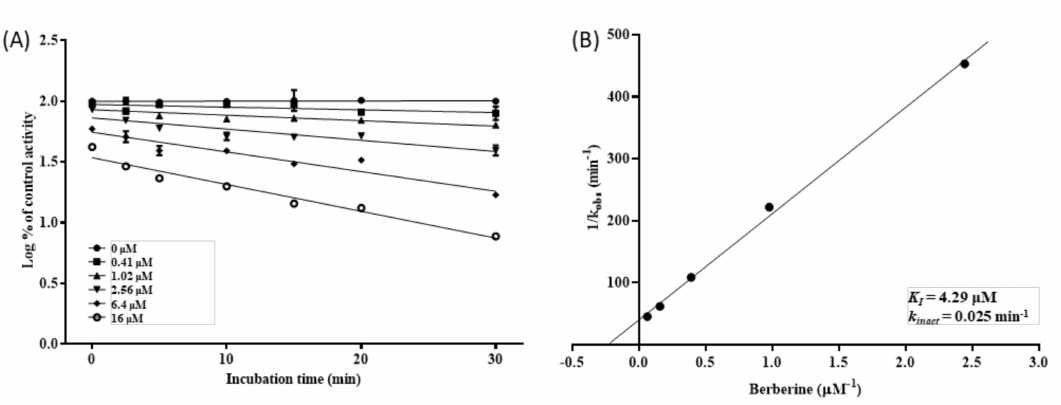
Figure 4. Time-dependent inhibition of CYP2D6 by BBR. ( A ) BBR was incubated for 0, 1, 5, 10, 15, or 30 min with NADPH in pooled HLM. CYP2D6 activity is expressed as the log percentage of control group containing no inhibitor at zero time. Data show the mean ± SD for three separate samples. ( B ) Double-reciprocal plot of k obs and BBR concentrations was plotted to determine K I and k inact for the inactivation of CYP2D6 by